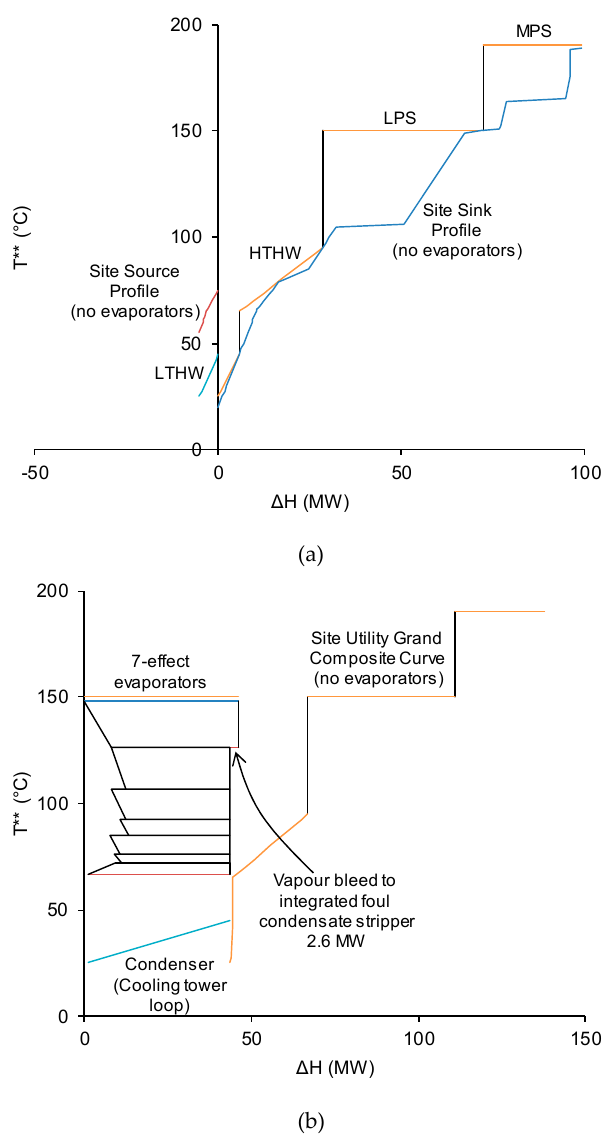
Figure 7. ( a ) Total site profiles and ( b ) site utility grand composite curve with existing integration for a conventional 7-effect black liquor evaporator.